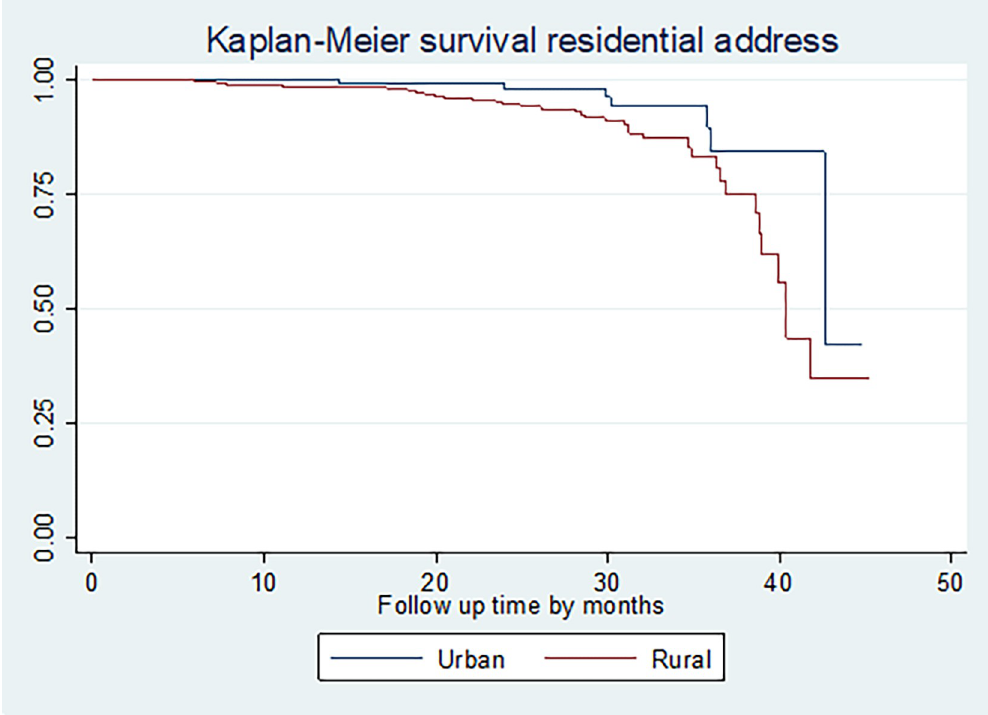
Fig 2. The Kaplan-Meier survival curves comparing survival time of cervical cancer patients by residential address in Felege Hiwot Comprehensive Specialized Hospital Oncology Center, Ethiopia (n = 422, by residence, n = 422, March